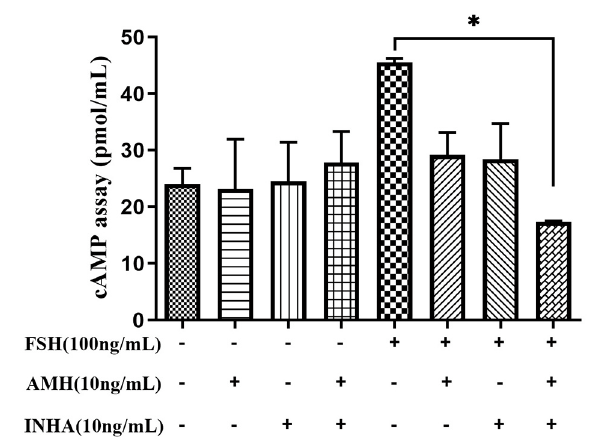
FIGURE 4 | Effects of INHA, AMH, or FSH alone or their combinations on the content of intracellular cAMP in primary granulosa cells after 30min of culture. Data are expressed as mean ± SEM, * p < 0.05 between the indicated experimental conditions.